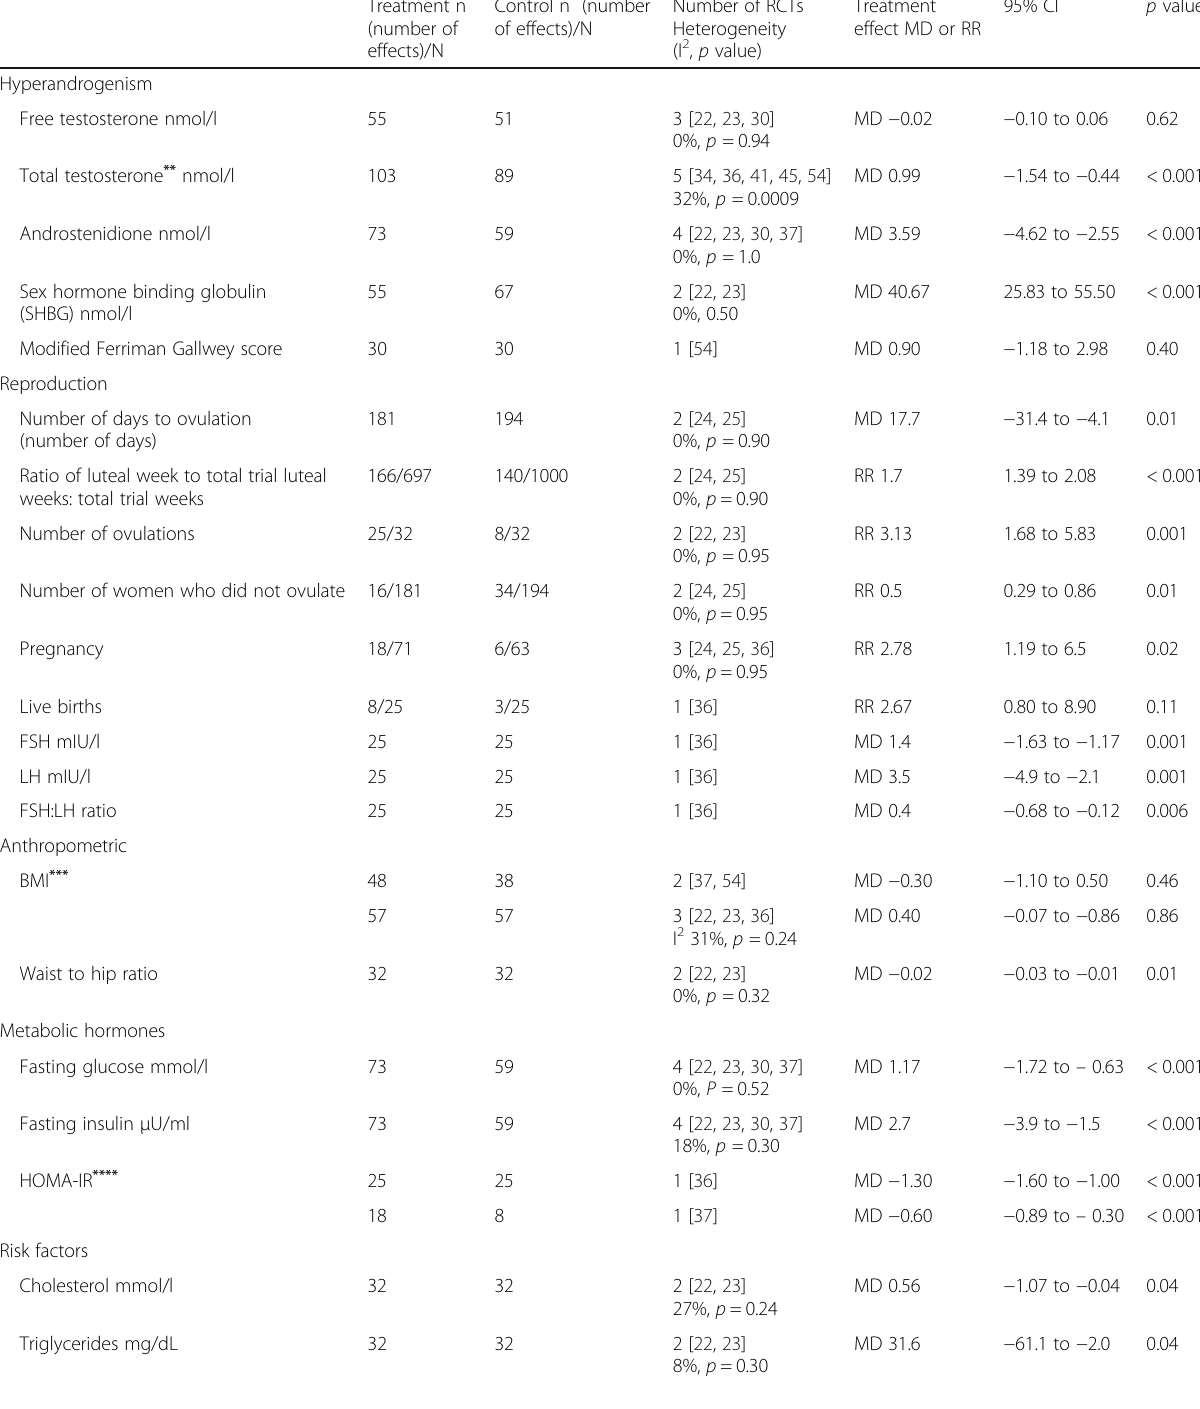
Table 2 Inositol for reproduction, hyperandrogenism, metabolism, anthropometry and risk